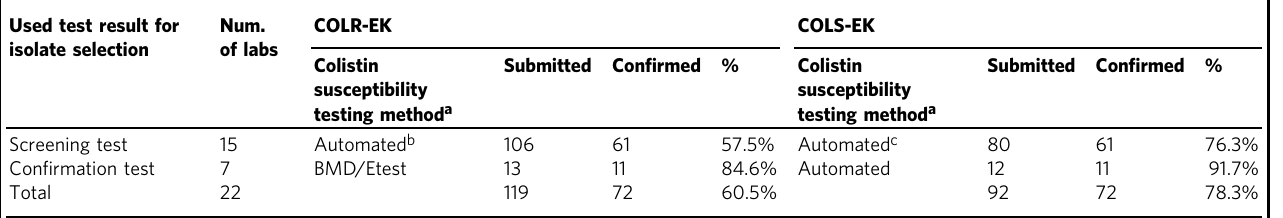
Table 3 Colistin susceptibility testing policies and con fi rmation of submitted isolates. Used test result for isolate selection